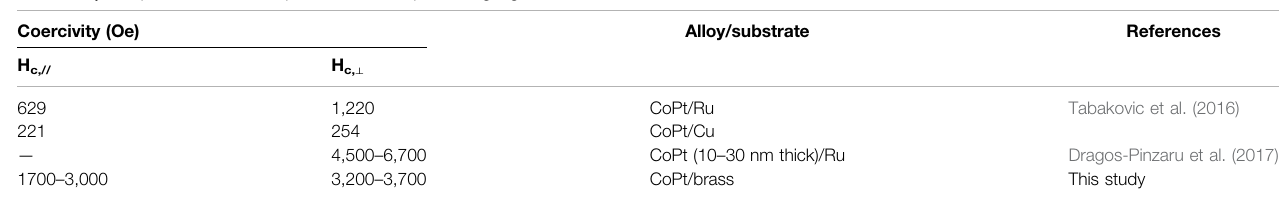
TABLE 3 | Comparison of some important results representing high coercivities in CoPt/CoPtP thin fi lms. Coercivity